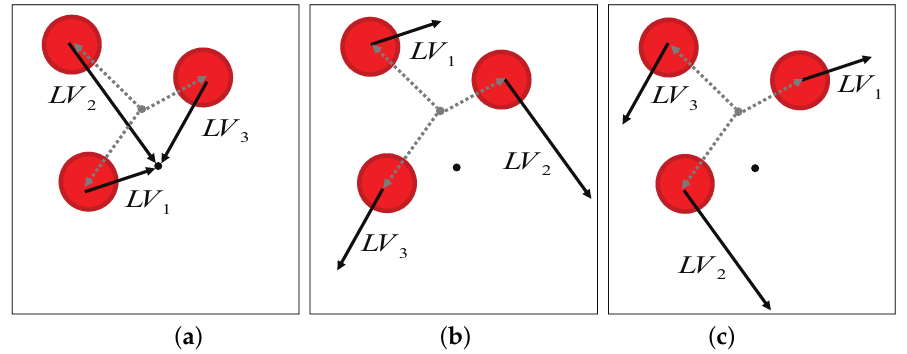
Figure 4. Projecting landmark vectors onto the reference map in different arrangement orders, and the correct order can be determined with the deviation of end points of projected landmarks (( a ) for the best matching case, and ( b , c ) for other matching